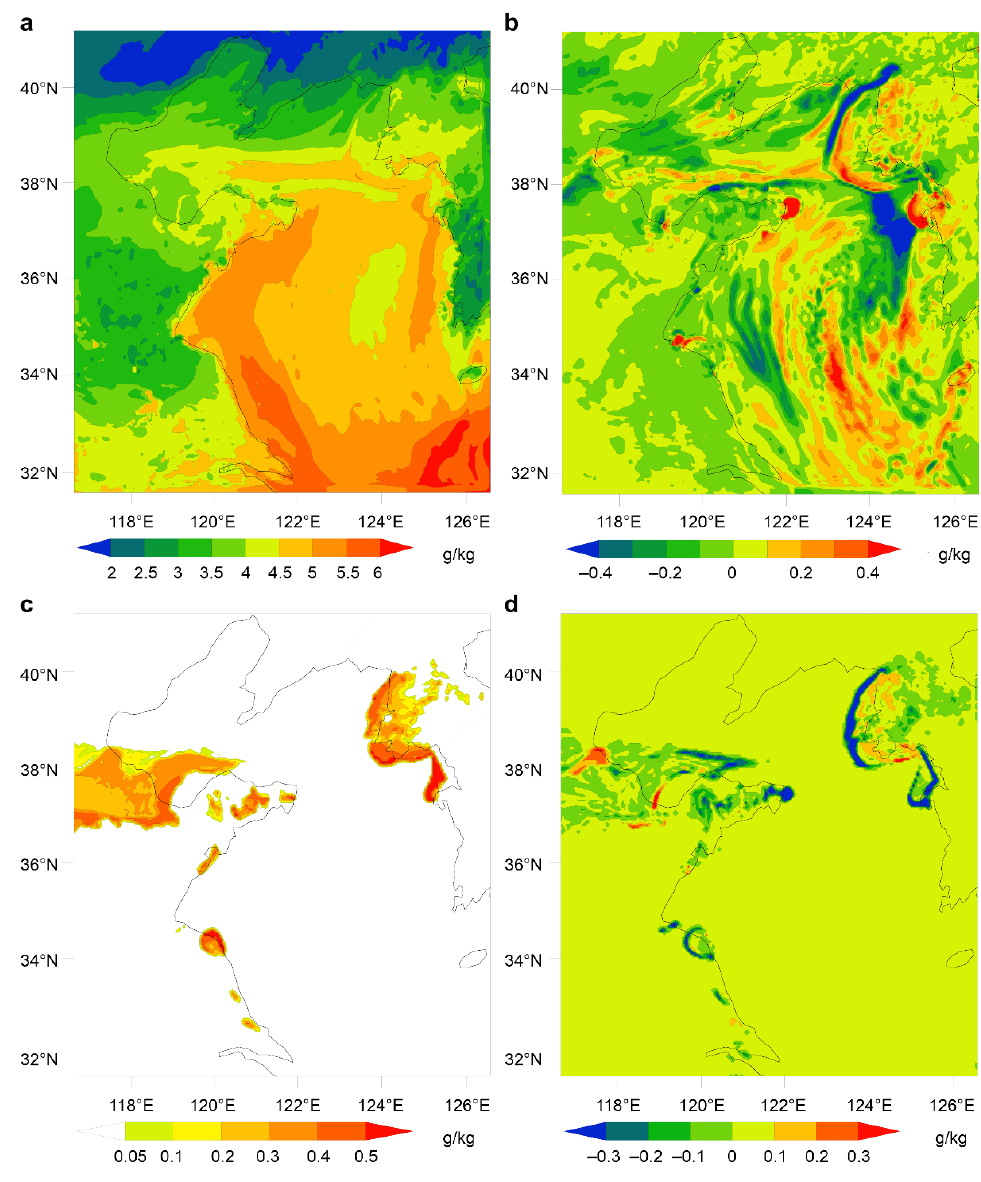
Figure 10. CODAS simulated specific humidity and liquid water content at 2 m and its difference with respect to FNL simulated results at 00:00 on 20 February 2020 for 48-h forecasting. ( a ) Specific humidity of CODAS at 2 m, ( b ) specific humidity difference between CODAS and FNL, ( c ) liquid water content of CODAS, and ( d ) liquid water content difference between CODAS and FNL.